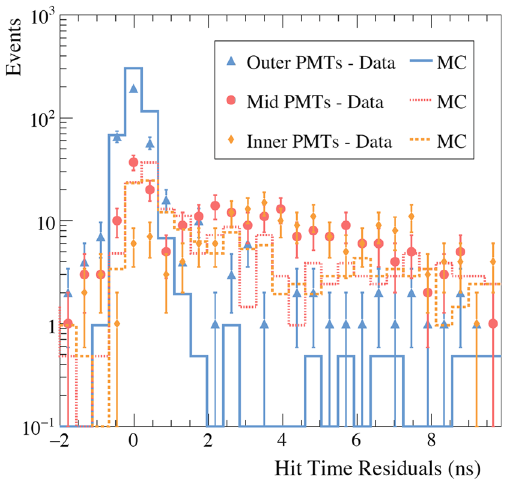
Fig. 7 Hit-time residual distributions in LAB for data and MC